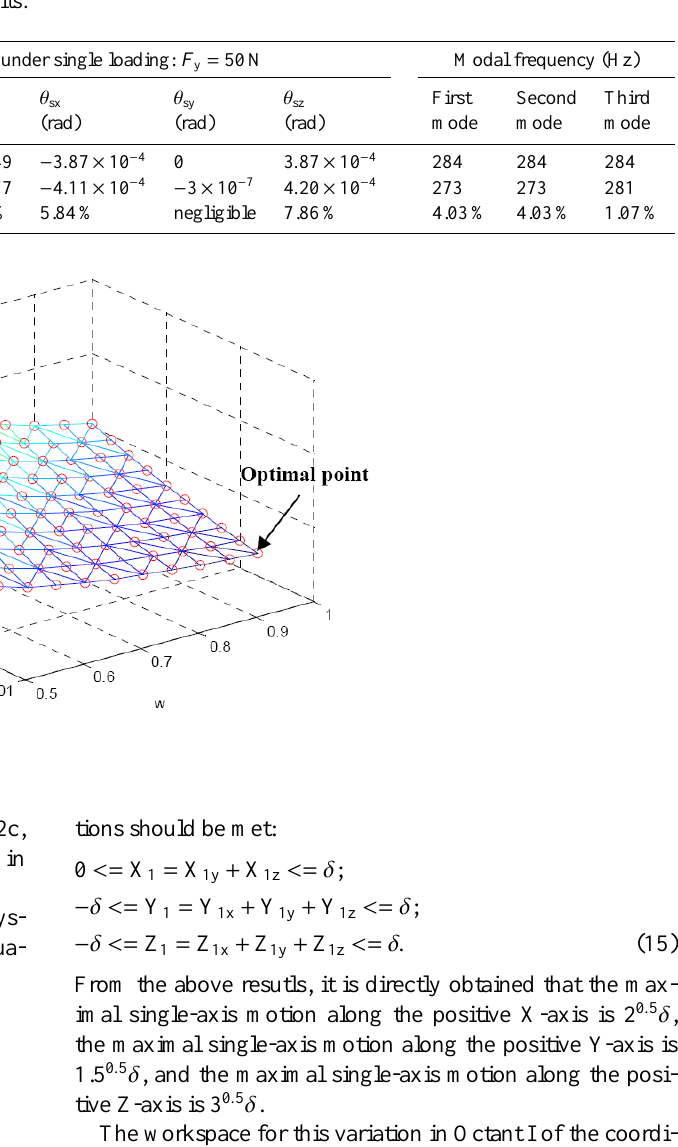
Table 1. Comparisons of the analytical results and the FEA results.